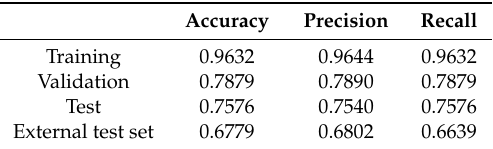
Table 2. Performance of ResNet-50 classification on training, validation, and test sets. Accuracy, precision, and recall are used for evolution.